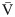
Schematic depicting the hypercapnic challenge completed by subjects at Baseline and 6-month follow-up.Cerebrovascular reserve was calculated using four distinct approaches: “Lower” considered the ΔV¯P/ΔPETCO2 during the +1.0 to +5.0 mmHg step change in PETCO2; “Upper” considered the ΔV¯P/ΔPETCO2 during the +5.0 to +8.0 mmHg step change in PETCO2; “Span” considered the total ΔV¯P/ΔPETCO2, where Δ was calculated as the difference between +8.0 mmHg and +1.0 mmHg values; and “Regression” calculated the slope of the response across the three stages.